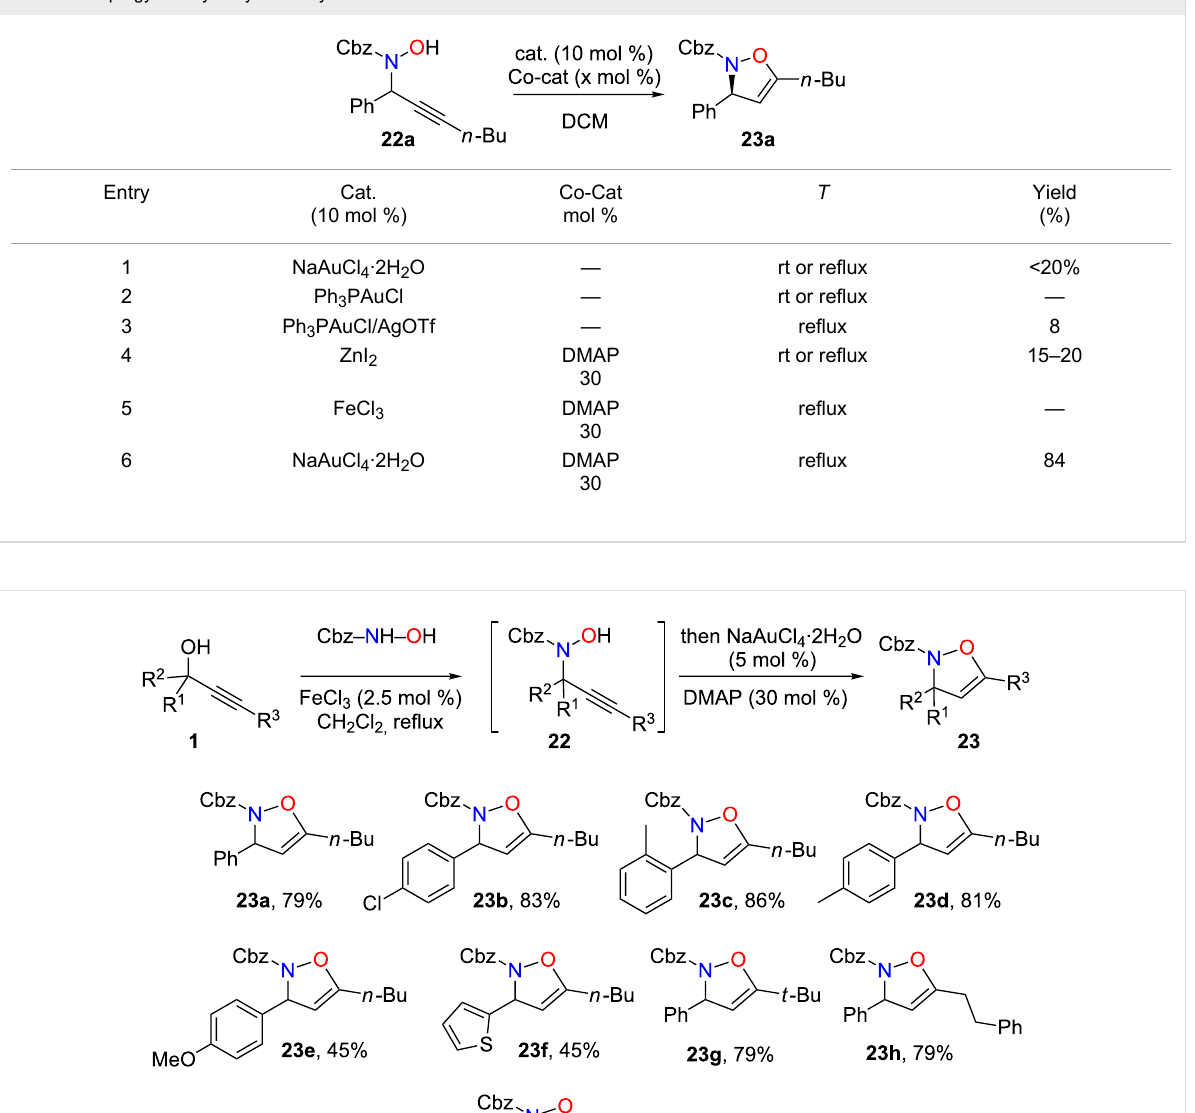
Table 2: Propargylic N -hydroxylamine